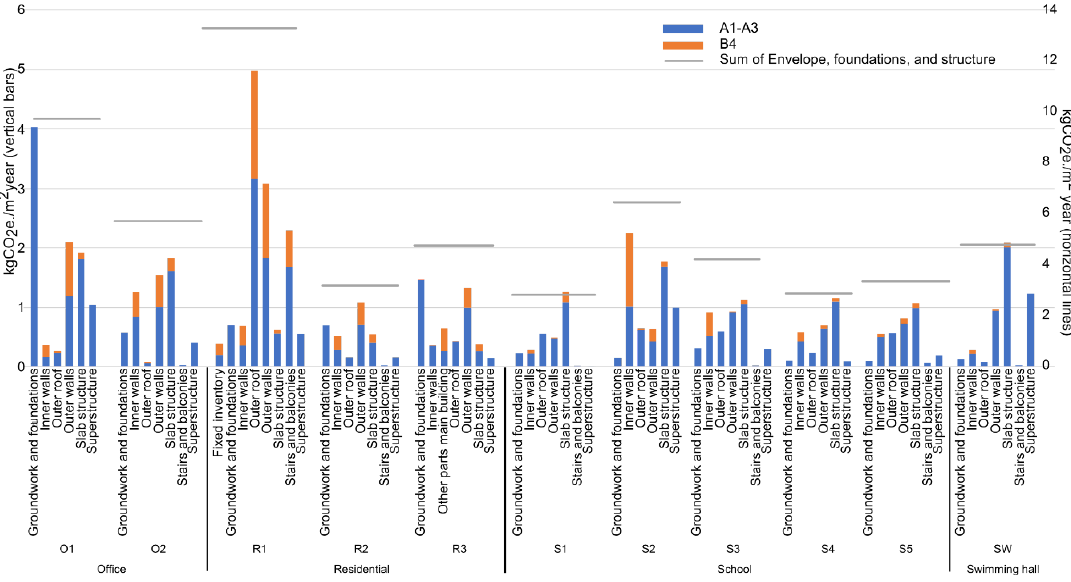
Figure 3. The embodied emissions in kgCO 2 e./m 2 year from material production (A1–A3) and replacements (B4) for 11 buildings from four different typologies. The building elements in the category “Envelope, foundation, and structure” are shown for each building (left axis) together with the total for this building element (right axis).